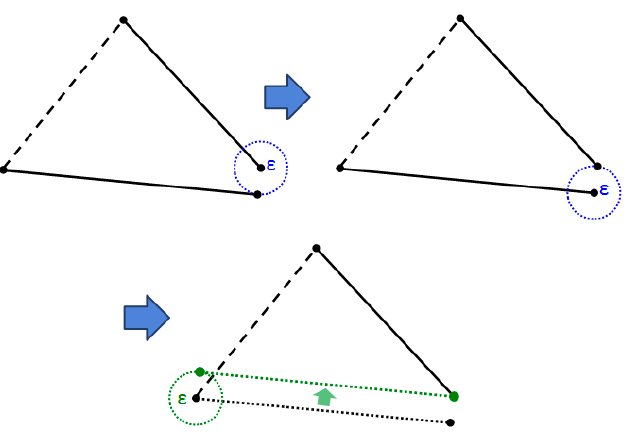
Figure 10. Geometrical symmetry.